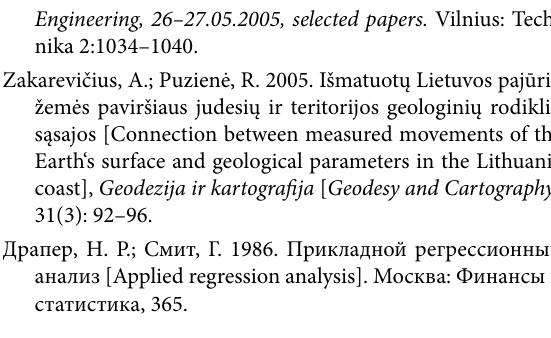
Fig 3. Prognoses and measured vertical movements of Earth surface during